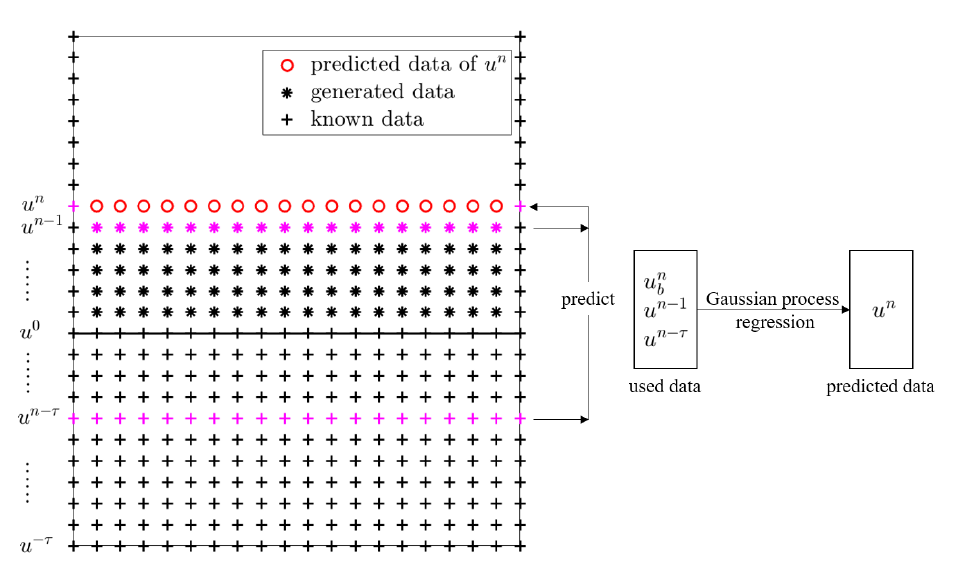
Figure 1. Basic workflow of